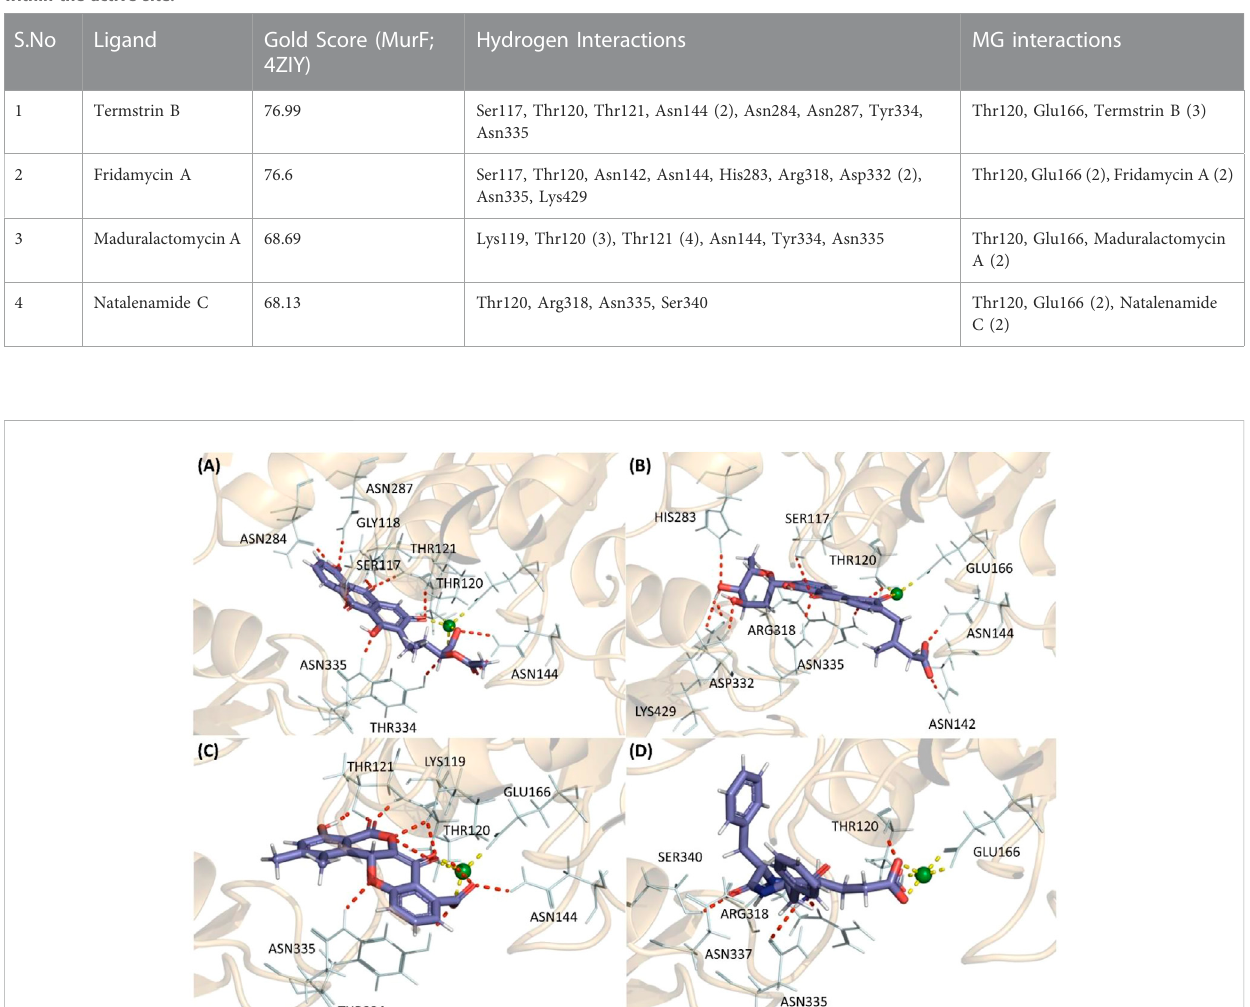
TABLE 3 The table lists the molecular docking scores, hydrogen interactions of the candidate drug and protein as well as the hydrogen interactions of the Mg ion within the active site.